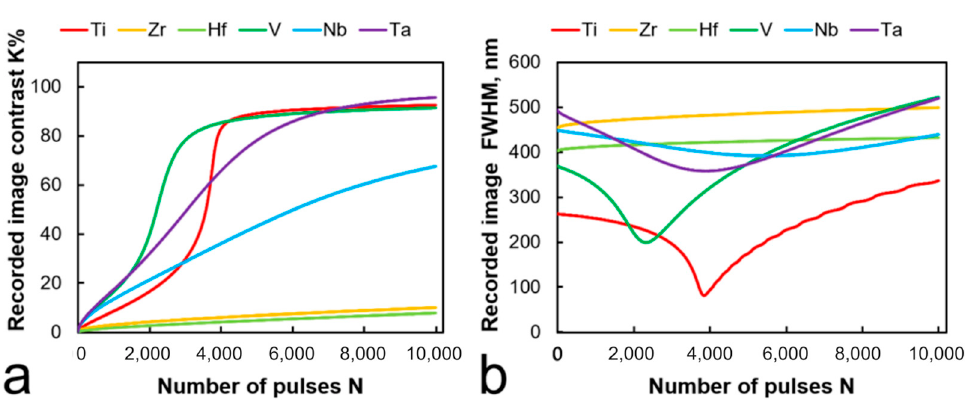
Figure 12. Estimated contrast ( a ) and respective FWHM ( b ) of the elements recorded on the films of various metals. The initial thickness of each film is 60 nm, radiation wavelength is 532 nm, and fluence ε 0 was chosen to match the melting point of each film respectively. Thus, ε 0 equals 0.2 J/cm 2 for Ti, 0.19 J/cm 2 for Zr, 0.3 J/cm 2 for Hf, 0.3 J/cm 2 for V, 0.4 J/cm 2 for Nb, and 1.0 J/cm 2 for Ta.